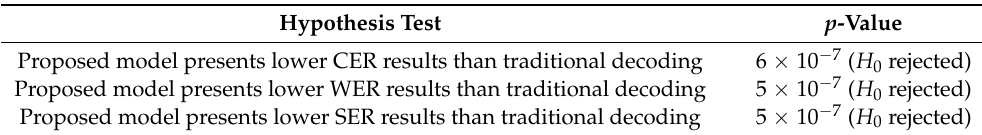
Table 7. Statistical analysis ( α =